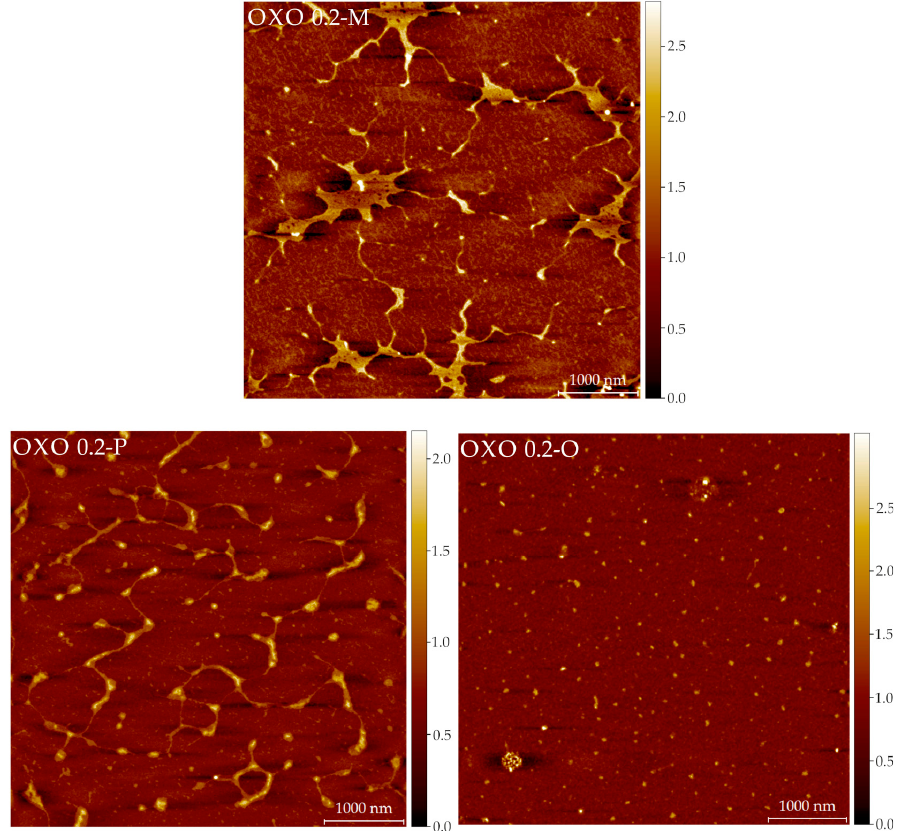
Figure A2. Representative images (5 × 5 μ m) of the OXO 0.2 fractions after IEC but before SEC separation ( top ) and after SEC fractionation ( bottom left , polysaccharide fraction, bottom right , low molar mass components). The color scale on the right indicates the height in nm.